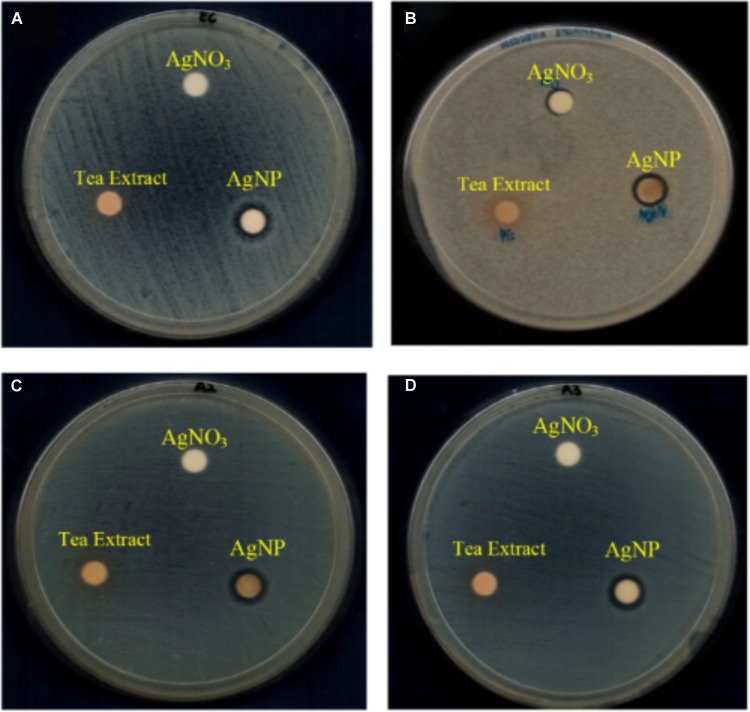
Visible clear zone produced by tea leaves extract mediated AgNP against four species of foodborne pathogens: (A)
E. coli ATCC 25922, (B)
K. pneumoniae ATCC 13773, (C)
S. Typhimurium ATCC 14028, and (D)
S. Enteritidis ATCC 13076.